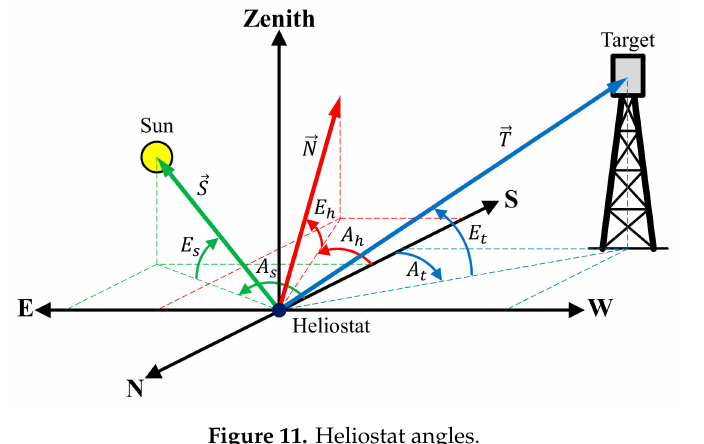
Figure 11. Heliostat